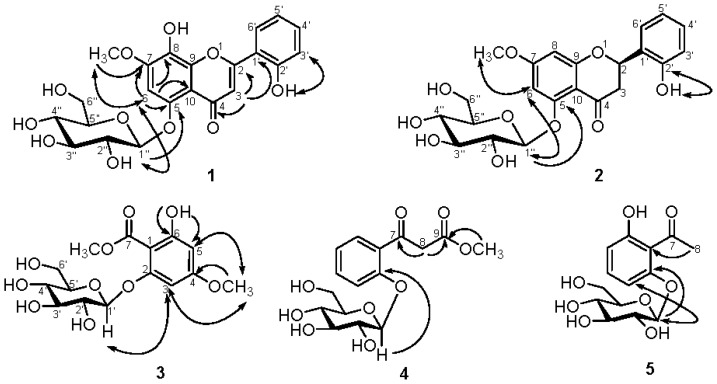
Selected HMBC (→) and NOESY (→) spectrum for compounds 1–5.